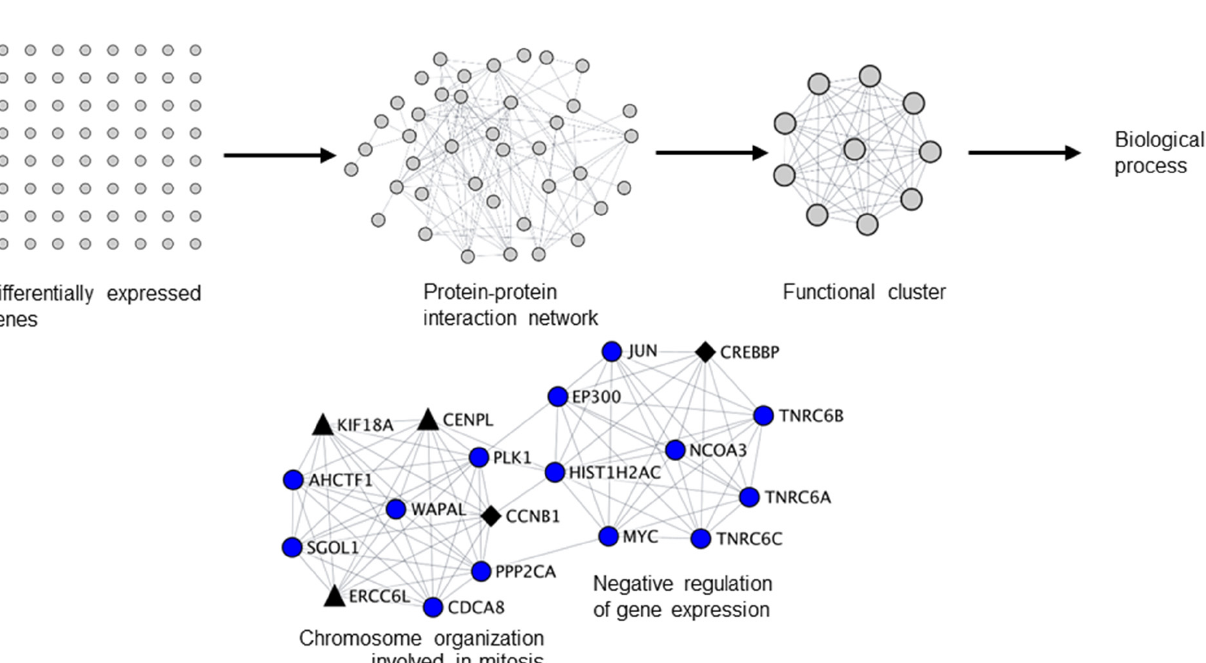
Figure 2. Biological clustering analysis (BCA) reveals cell cycle related functions for NANOS1 and NANOS3. ( A ) Workflow for biological clustering analysis (BCA). High confidence (score ≥ 0.9) pro- tein–protein interaction networks of differentially expressed genes are created using the STRING database followed by cluster detection by MCODE. Further, these clusters were subjected to gene ontology (GO) search for the corresponding biological process. ( B ) NANOS1 and ( C ) NANOS3 downregulated cell cycle cluster containing infertility (shown in black diamonds, Supplementary Table S3) and cancer-germ cell genes (shown in black triangles, Supplementary Table S4). 2.3. Distinct Phenotypic Effects of NANOS1 and NANOS3 on Cell Cycle The results of RNA-Seq, BCA, and GO analysis of NANOS downregulated genes in- dicate that both NANOS1 and NANOS3 proteins play a role in regulation of the cell cycle in TCam-2 cells. To further explore the effect of these proteins on the cell cycle, we over- expressed NANOS1 and NANOS3 and performed cell cycle analysis by propidium iodide staining followed by flow-cytometry analysis. In the case of NANOS1 overexpression, we observed a higher number of cells in G1 and G2/M phases and fewer in S phase compared to control cells, (Figure 3B top panel). The effect of NANOS1 on the cell cycle is consistent with GO indication that NANOS1 represses genes involved in the G1/S phase transition (Figure 3A top panel, Table S2). Moreover, GO analysis indicates that NANOS1 represses genes involved in the p53 mediated DNA damage checkpoint process which takes place during S phase. Downregulation of this phase accelerates both cell proliferation and S